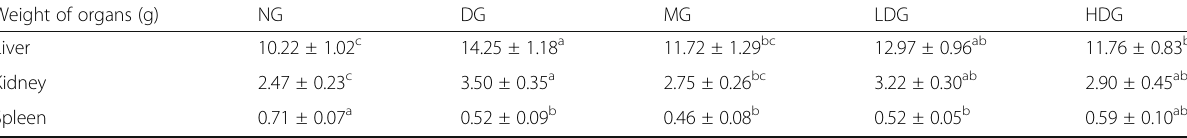
Table 2 Weight of rat body organs liver, kidney and spleen Weight of organs